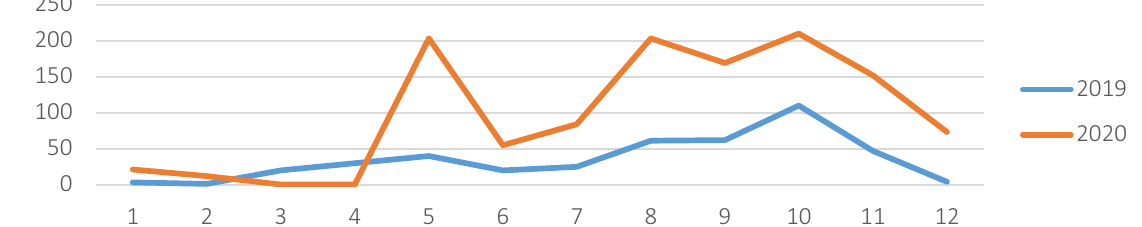
Figure 9. Monthly distribution of the number of the B2B meetings with Ukrainian participants